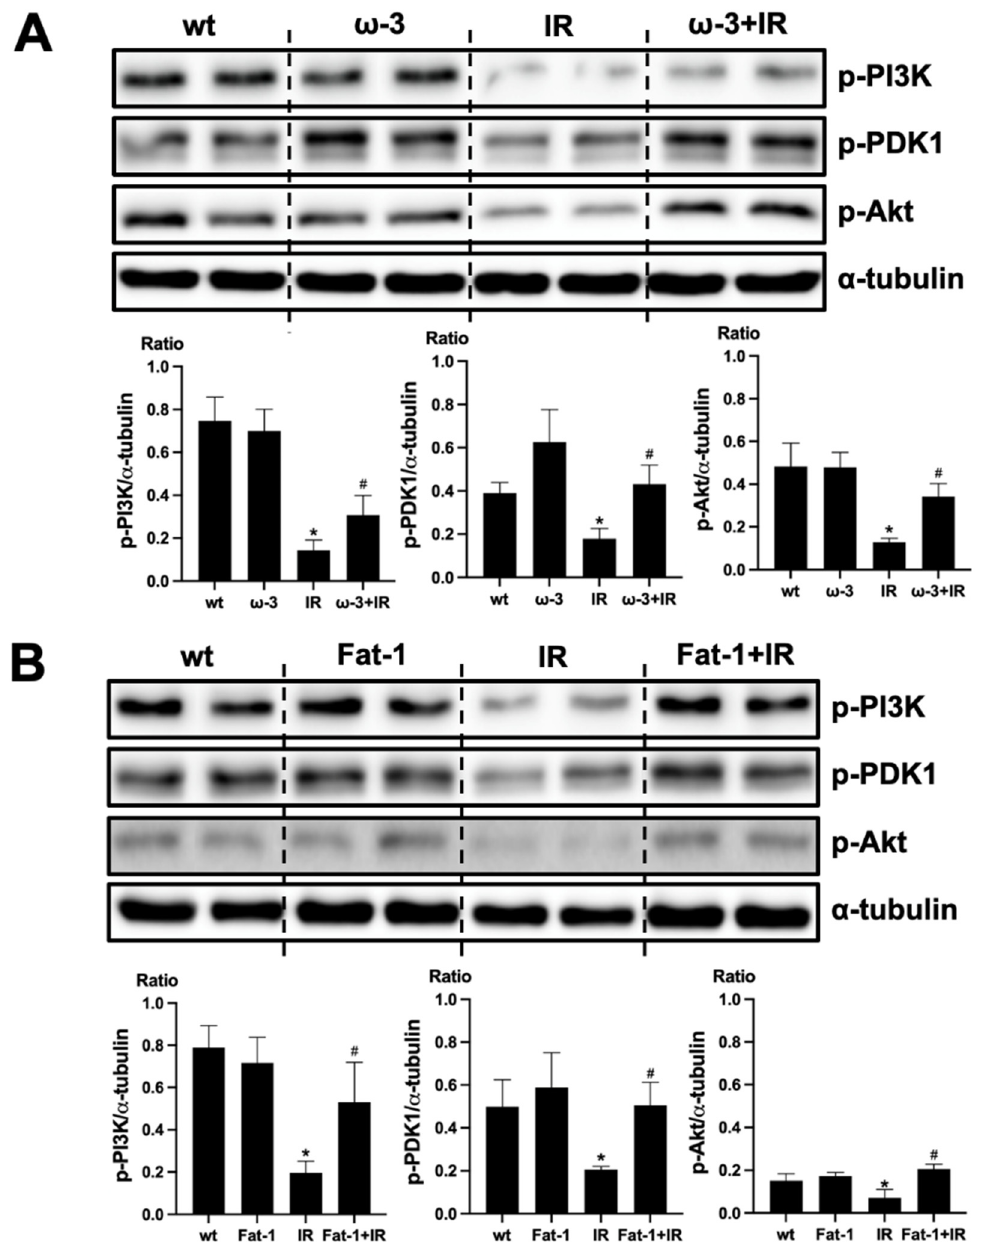
Figure 5. Effects of ω -3 PUFA on PI(3)K/Akt signaling. ( A ) Representative Western blot of brain lysis: The brain of ω -3 PUFA orally administered IR-injured mice shows increased p-PI3K, p-PDK1, and p-Akt expression compared to IR-injured mice. ( B ) Representative Western blot of brain lysis: The brain of IR-injured Fat-1 mice showed increased p-PI3K, p-PDK1, and p-Akt expression, compared to that of IR-injured mice. * p < 0.001 vs. wt, # p < 0.001 vs. IR. Bar represents mean ± S.D. (wt, wild-type sham; ω -3 PUFA, ω -3 PUFA oral administration sham; Fat-1, Fat-1 induction sham; IR, IR renal injury in wild-type mice; ω -3+IR, IR renal injury in ω -3 PUFA oral administration mice; Fat-1+IR, IR renal injury in Fat-1 induction